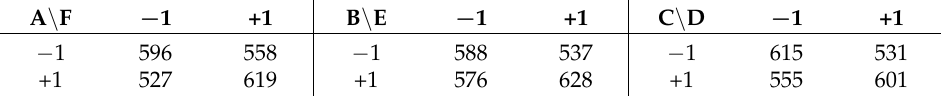
Table 10. Analysis of the interactions AF+BE+CD versus hardness in Region II. A \ F